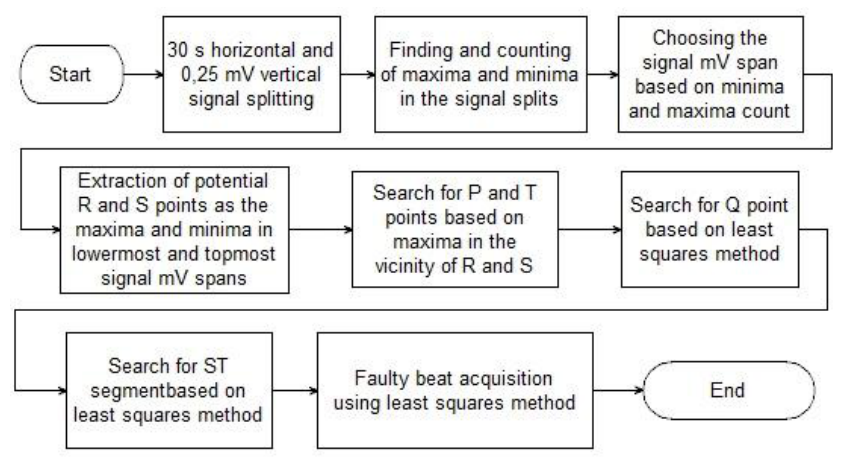
Figure 3. Flowchart of the heartbeats extraction